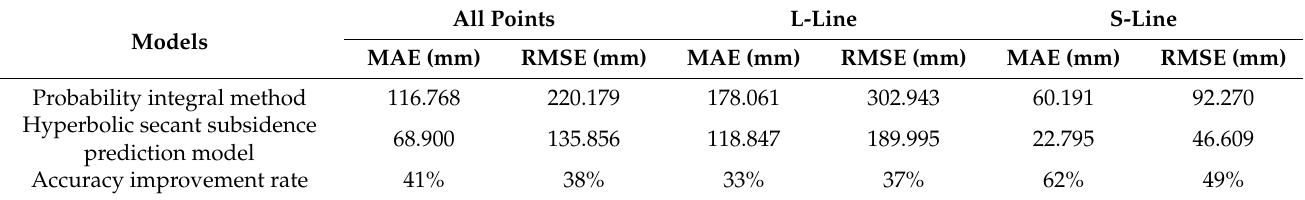
Table 2. Model prediction error.